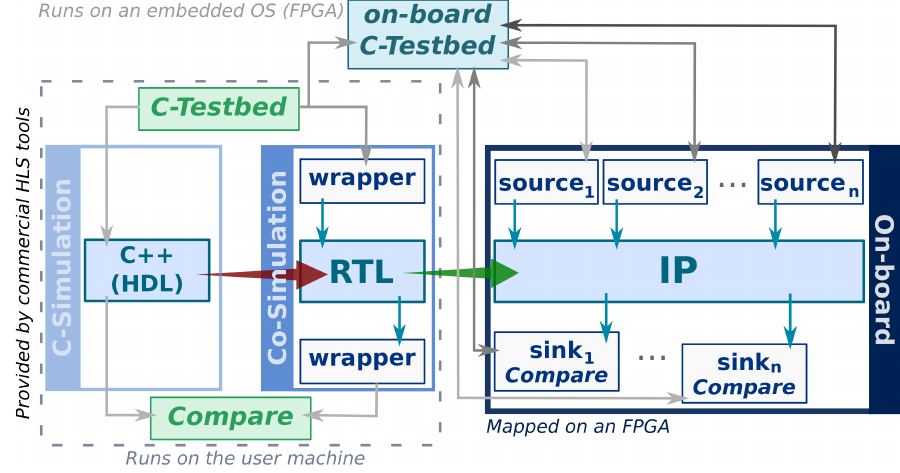
Figure 1. Big picture of the proposed